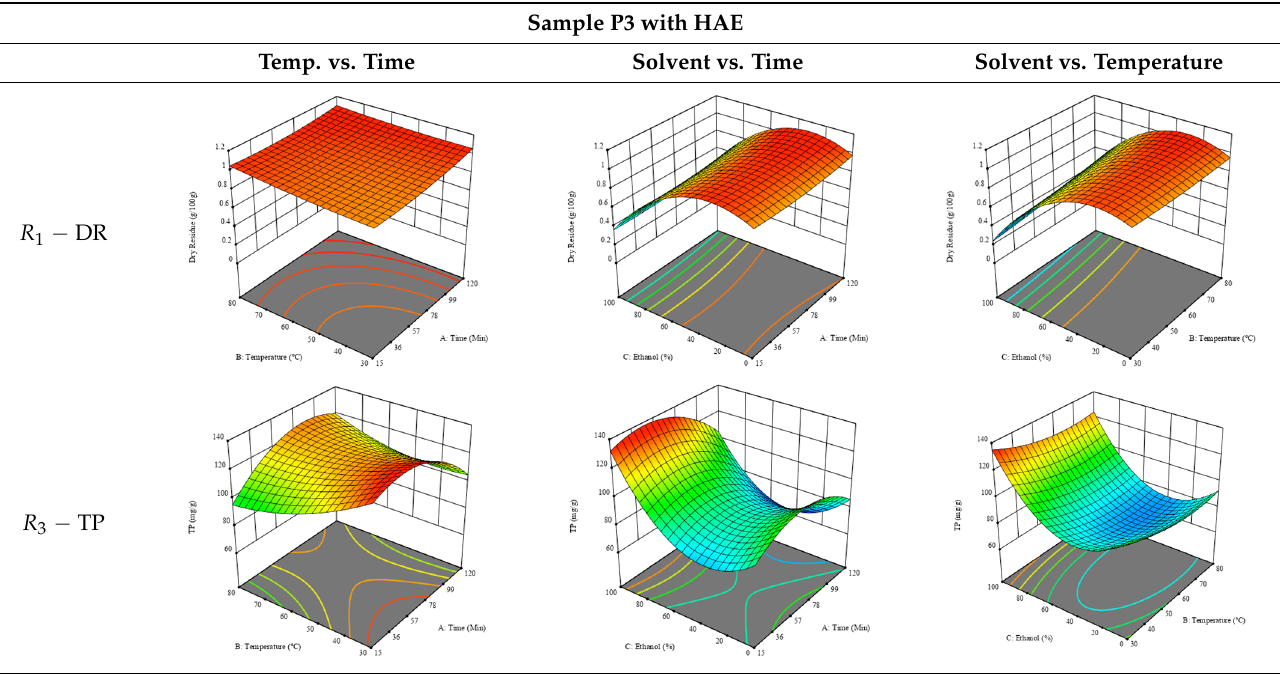
Table 9. 3D response charts of the heat-assisted extraction (HAE) of ‘Leuka melitis’ peel (P3) at the optimal values. Sample P3 with HAE Temp. vs. Time